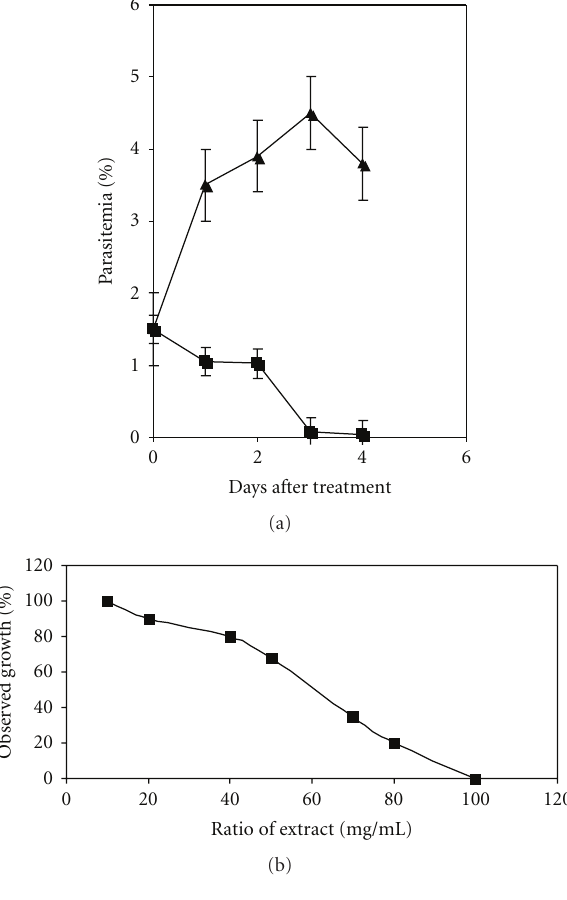
Figure 1: (a) Growth of the chloroquine-susceptible P. falciparum strain NF54 in the presence of a diluted extract from Balanite seeds obtained from a 1:2000 ratio of seeds to extract. Parasites were grown in 12-well microculture trays. Triangles indicate parasitemias of the untreated NF54 control while rectangles indicate the drug- treated strain. Each point represents the mean value of four di ff erent determinations with ± standard deviations. (b) Dose- response curve of the crude extract from Balanite seeds (extract mg/mL) versus the percentage of the determined parasitemia.